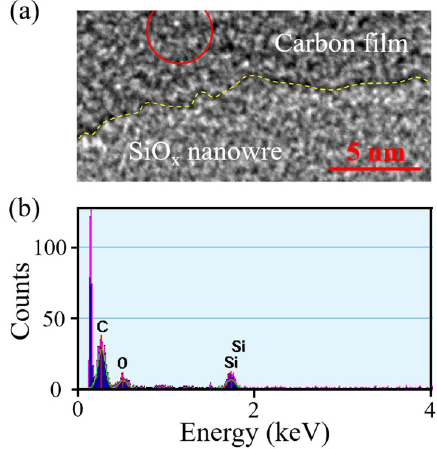
Fig. 2 a HRTEM image showing the microstructure and high- quality of welding region between SiO nanowire and carbon film, x which corresponds to the yellow rectangular-box location in Fig. 1i; b EDS data showing the chemical composition of the red circle location (diameter: ~ 3.6 nm) in a , which is on the side of macropo- rous carbon film and close to the yellow dashed welding